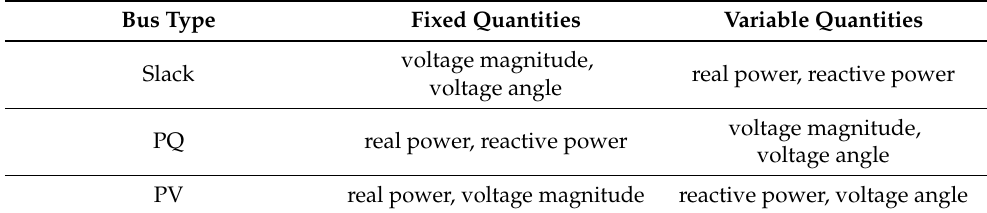
Table 1 collects the quantities for each bus type. Table 1. Bus Classification Used In Power Flow Problems.